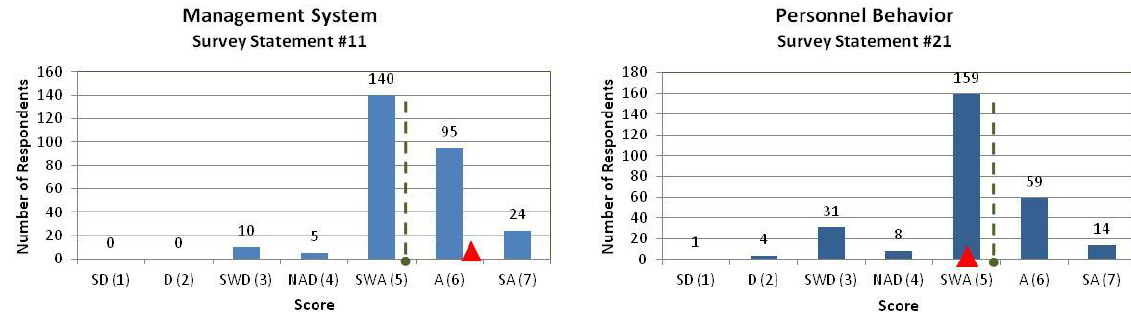
Figure 4. Examples of histograms of two survey statements. Fig. 5 depicts the average score of each characteristic. The dashed vertical line is the average score Pav. The average score of each indicator is placed in the green zone if the score is higher than 5, in the yellow zone if the score is between 4 and 5, and in the red zone if the score is lower than 4. As shown in Fig.